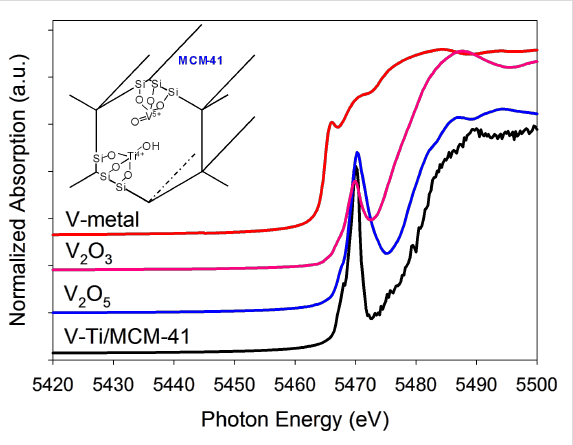
Figure 4: Summary of the V K-edge characterization of V-Ti/MCM-41 with references by XANES and proposed structures of V-Ti/MCM-41